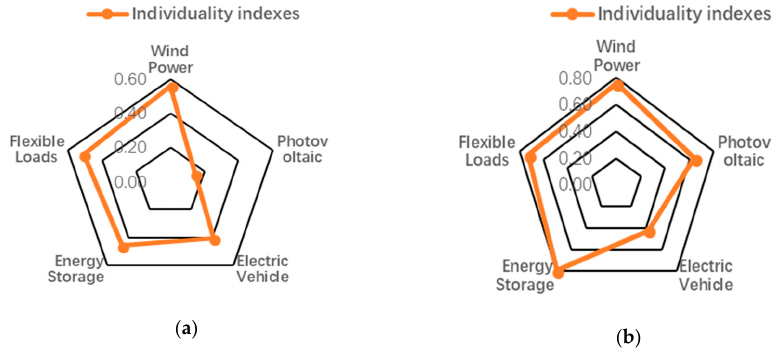
Figure 11. The comprehensive scores of individuality indexes of various DSER in a certain region. ( a ) The score of various DSER in region 1; ( b ) The scores of various DSER in region 2.